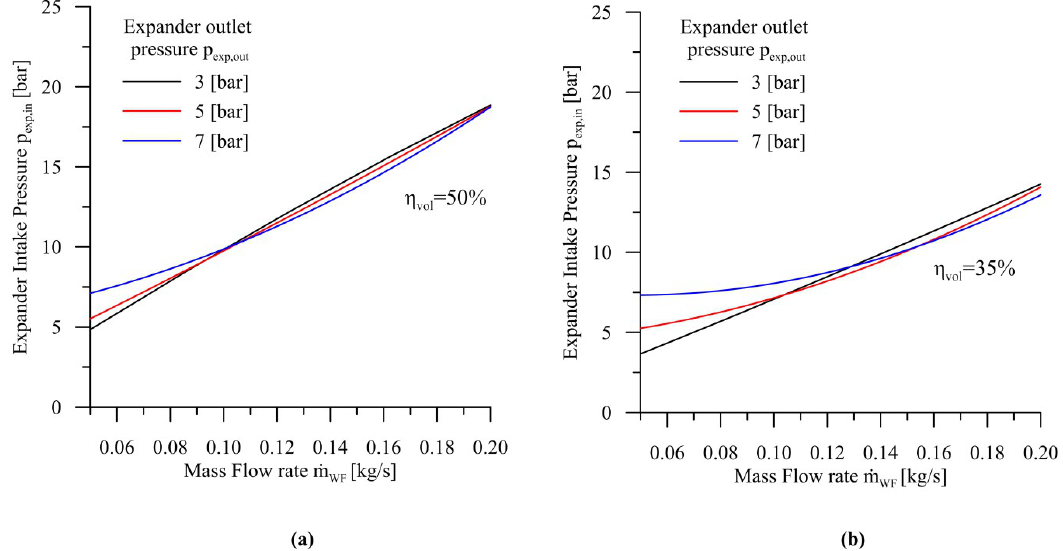
Figure 5. Expander intake pressure varying the mass flow rate provided by the pump and the expander outlet pressure when the expander volumetric efficiency is η vol = 50% ( a ) and η vol = 35% ( b ). On the contrary, for the machine with lower volumetric efficiency when the p exp,out was equal to 7 bar, the intake pressure trend was far from that corresponding to the cases in which p exp,out ranges between 3 bar and 5 bar. In particular, the increase of p exp,out led to higher intake pressure, keeping constant the ṁ WF considered. This happens when the machine has a lower volumetric efficiency because the clearance gaps are higher. Indeed, if the expander had not clearance ( η vol = 1) the communication between the intake and exhaust would not take place and p exp,out cannot influence the expander intake pressure. Thus the expander ideally breaks the whole circuit in two parts: A higher pressure side upstream the machine and a lower pressure side downstream it. Nevertheless, a clearance gap cannot be avoided in real construction, to guarantee the expander functionality and a communication between the intake and exhaust port happen. Therefore, the higher the clearance gap is the larger are the effects of p exp,out on intake pressure. A Model Based Diagnostic Procedure for SVRE The virtual platform allowed to represent the whole operating range covered by the machine in a control map as reported in Figure 6. In order to define control strategies, the use of the map can be more feasible than a real time model prediction in order to be stored in a conventional engine electronic control unit (ECU) [47]. The maps reported in Figure 6 allow to evaluate if the expander is working according to the expected condition or if anomalies are taking place. The maps represent the intake pressure trend as a function of ṁ WF provided by the pump for different values of volumetric efficiency of the expander. In order to consider also the effects of the condensing pressure on the intake pressure of the expander, a diagnostic map can be derived for several p exp,out . Therefore, entering the intake and exhaust pressure of the expander and the mass flow rate circulating inside the plant, the map detects if the expander is properly working. In fact, referring to Figure 6, once the p exp,out is known (by a measurement), the corresponding sub-map can be considered. From it, the evaluation of the expander volumetric efficiency can be univocally performed entering the intake pressure and mass flow rate measured.